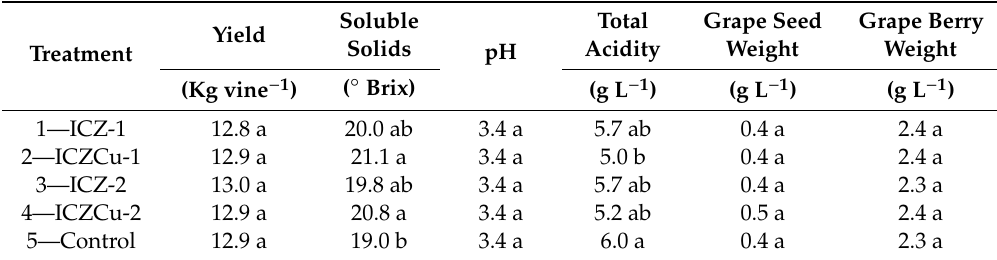
Table 5. Mean yield and main grape composition parameters recorded on 19 September 2019 at harvest in Trebbiano d’Abruzzo vines of Controguerra vineyard treated with Italian chabasite-rich zeolitite and Italian copper chabasite-rich zeolitite (ICZ and